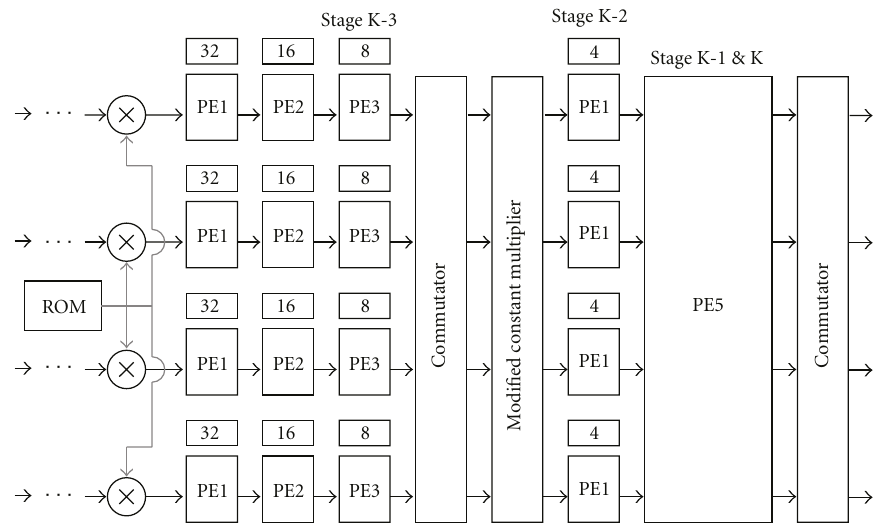
Figure 4: Architecture of a MIMO FFT processor with 4 channels.